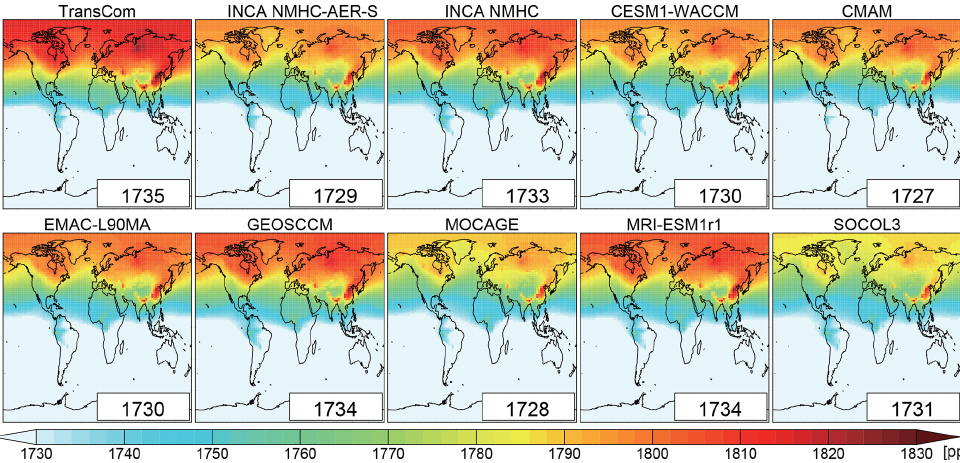
Figure 6. Spatial distribution of volume-weighted tropospheric mean CH 4 mixing ratios averaged from 2000 to 2010 as simulated by LMDz with different OH fields in the LMDz model. The global mean values (ppbv) are shown as